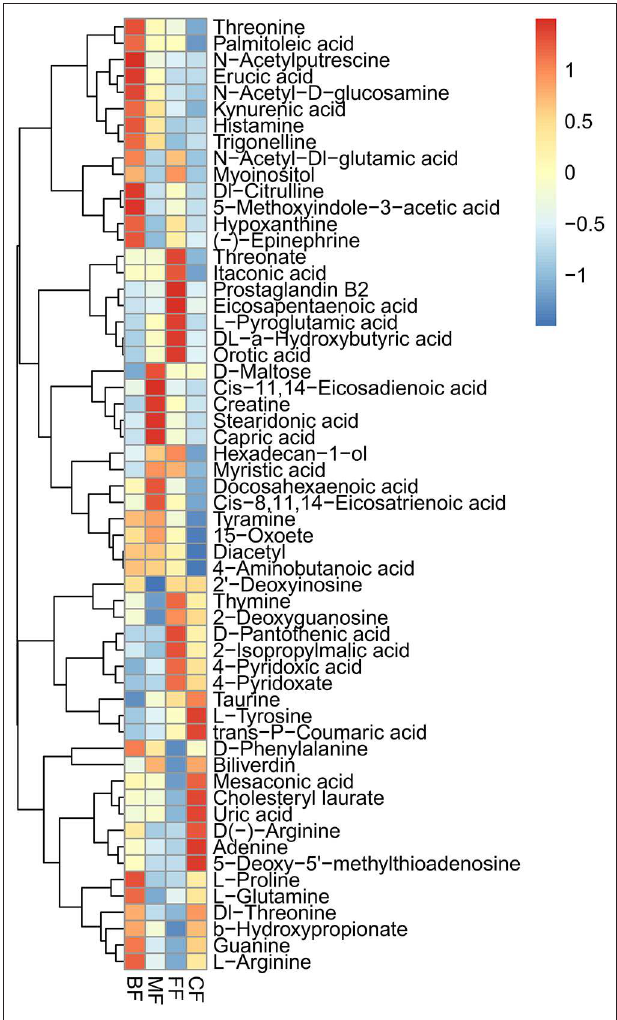
FIGURE 5 | Heatmap of the most abundant metabolites of four feeding methods, as identified by variable importance in projection (VIP) scores in partial least squares discriminant analysis (PLS-DA). Every column represents a different metabolite in stool samples. Higher abundances are marked in red color, whereas lower abundances in blue